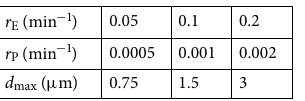
Table 1. Parameters used for the agent-based model biomechanics